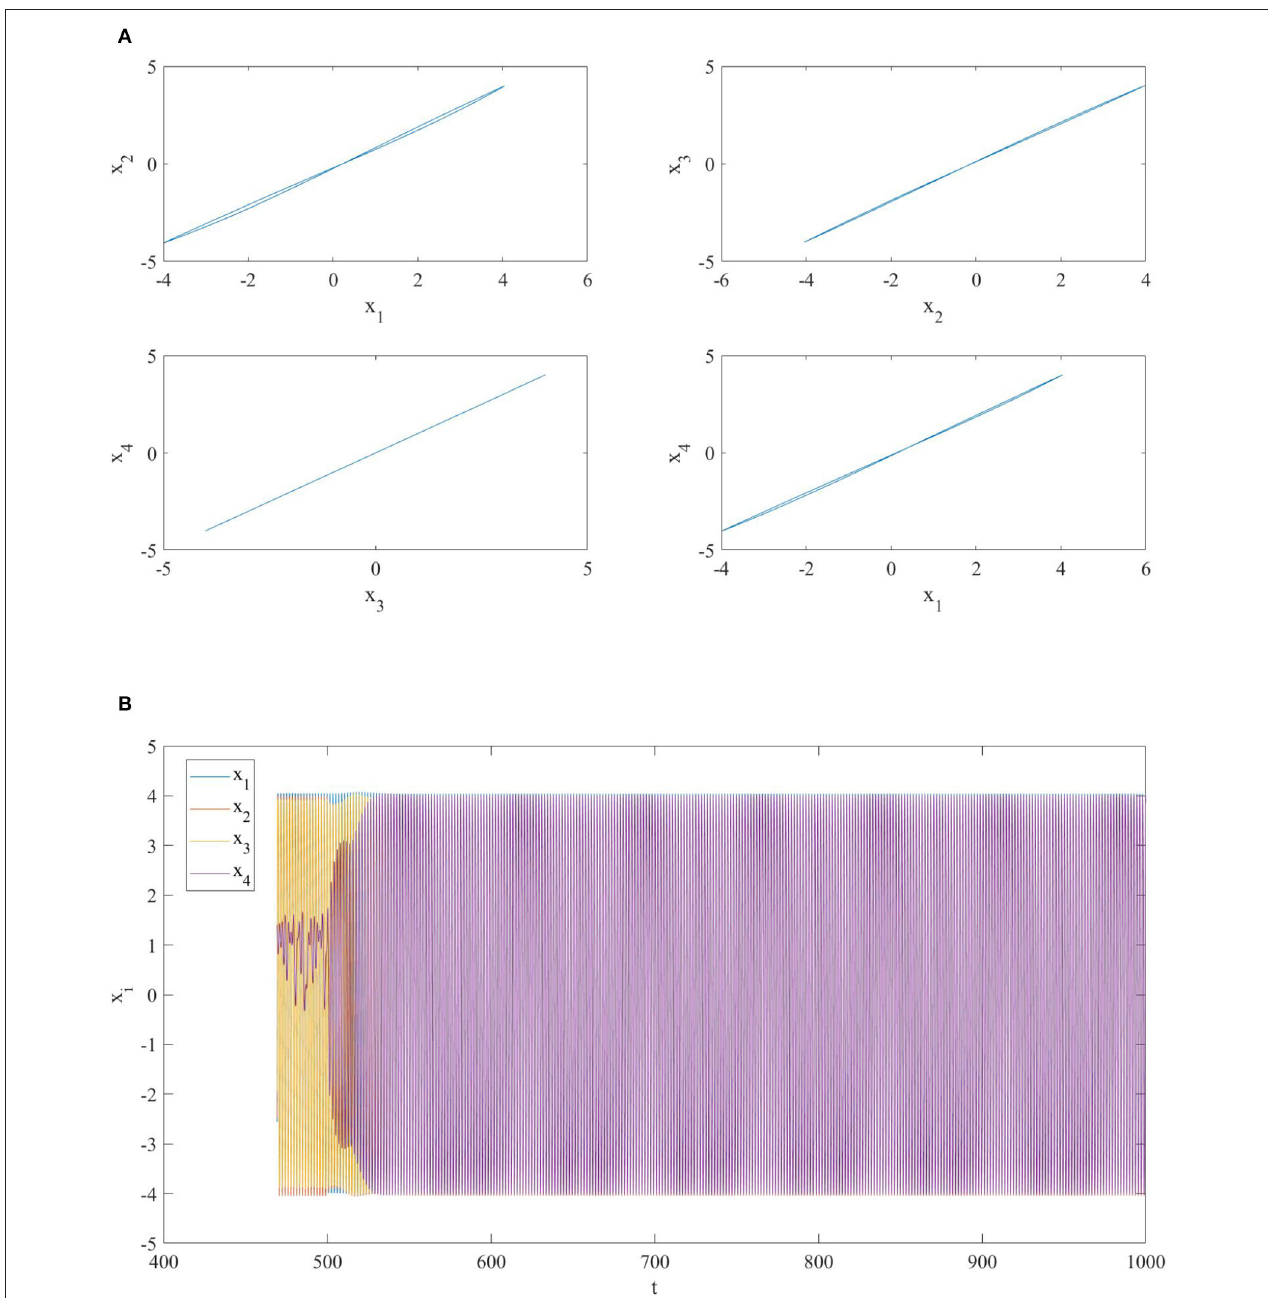
FIGURE 4 | (A) Phase portrait and (B) time series of a network of four diffusively coupled MOCs when a link between the first and the fourth oscillator is added at t = 500. The addition of this link makes all the oscillators to synchronize in